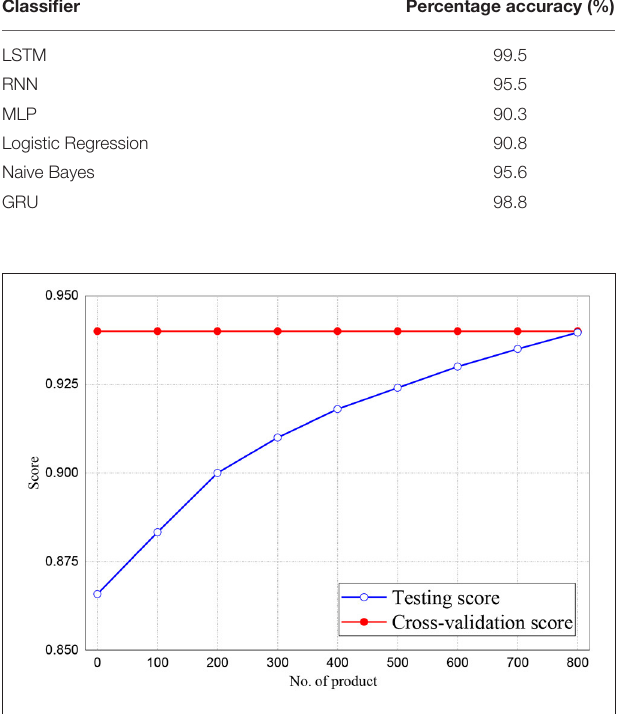
FIGURE 8 | Result of Testing and Cross-Validation for MLP